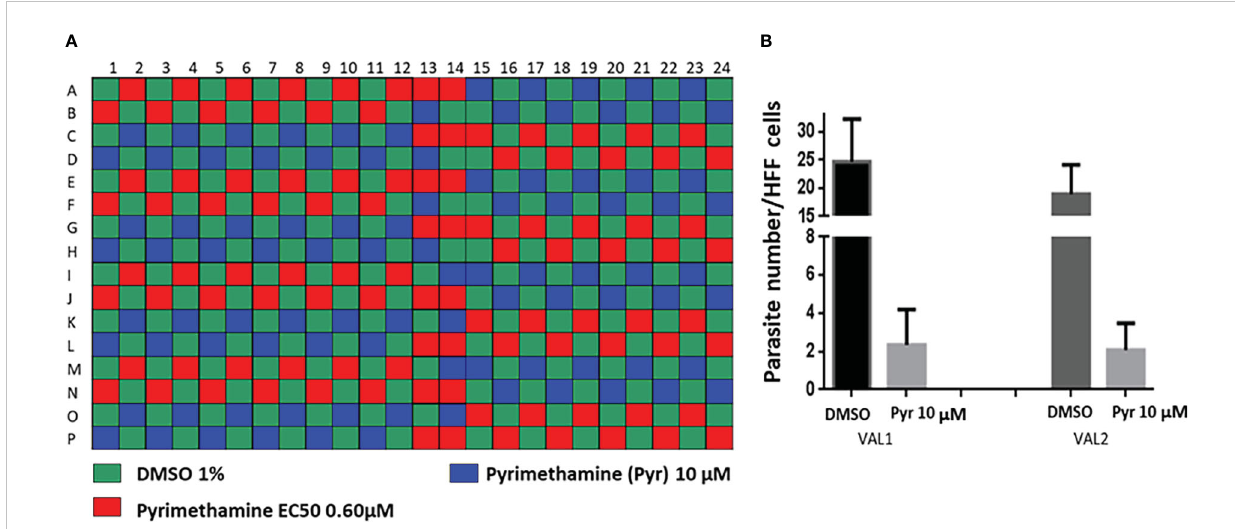
FIGURE 4 Pre-screen optimization using pyrimethamine, the well-known anti- Toxoplasma drug as control. (A) Checker-board layout; (B) Determination of the parasite number per HFF cells for DMSO and Pyr at 10-µM concentration. VAL1 and VAL2 correspond to the two analyzed